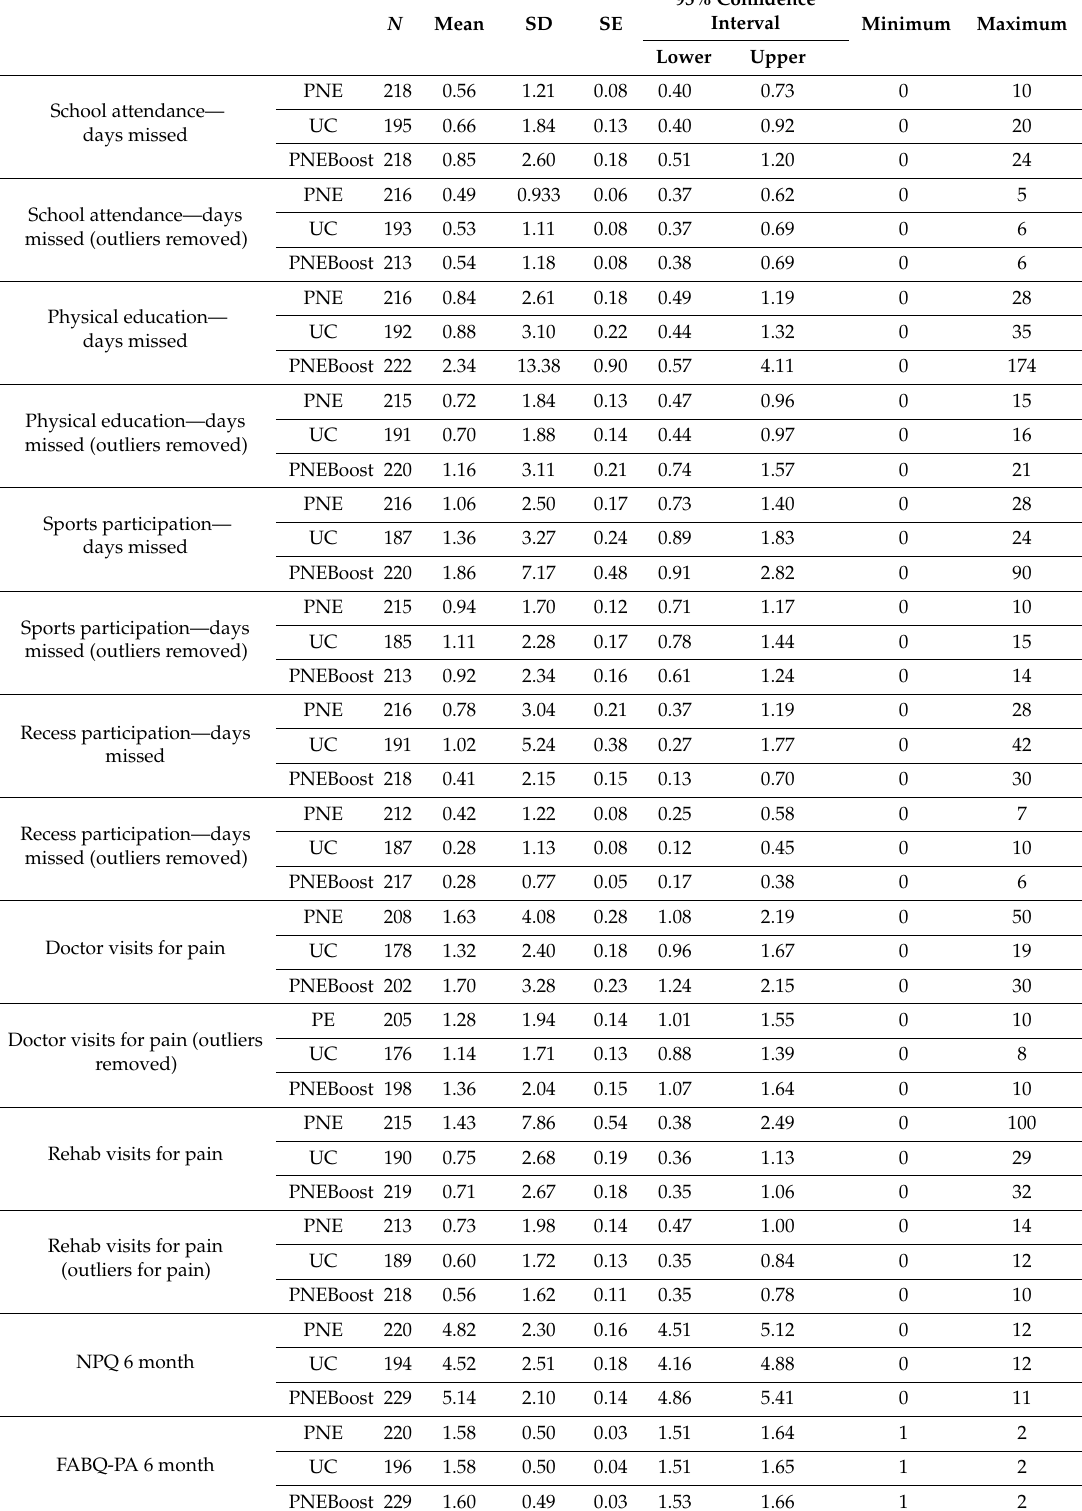
Table 2. Descriptive statistics, with and without outliers, for the comparison among the 3 treatment groups for each of the 6-month outcome